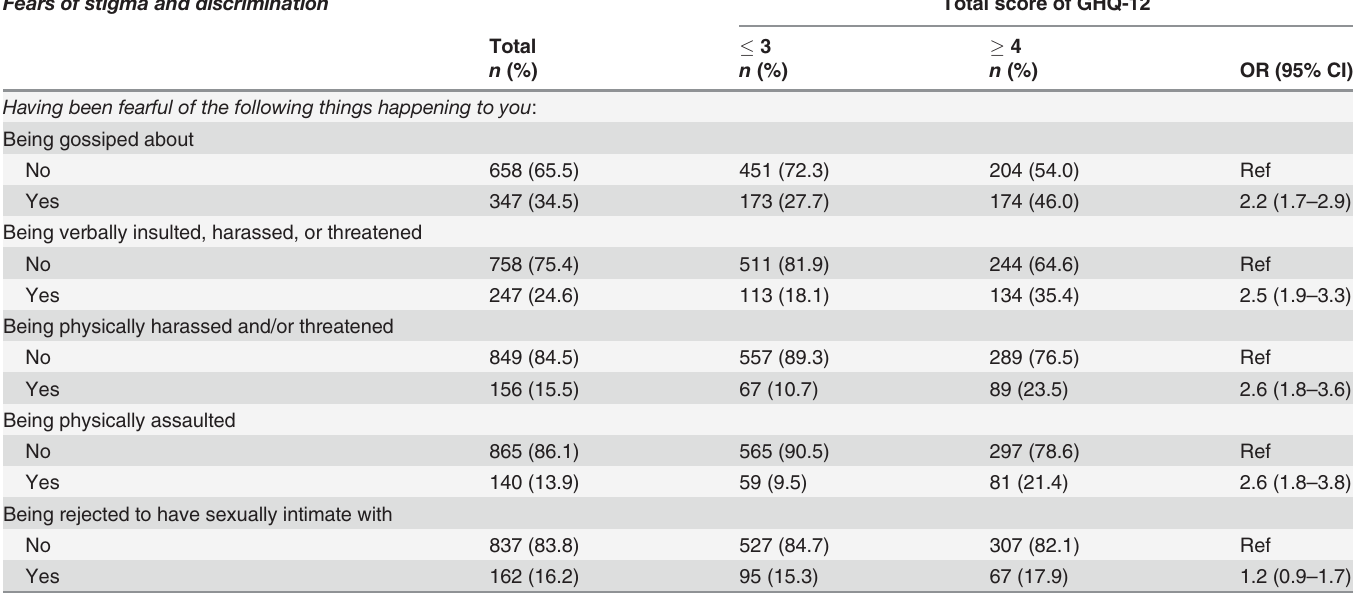
Table 4. Comparisons of fear of stigma and discrimination experienced in the past 12 months among PLHIV lower and higher levels of mental disorders. Fears of stigma and discrimination Total score of GHQ-12